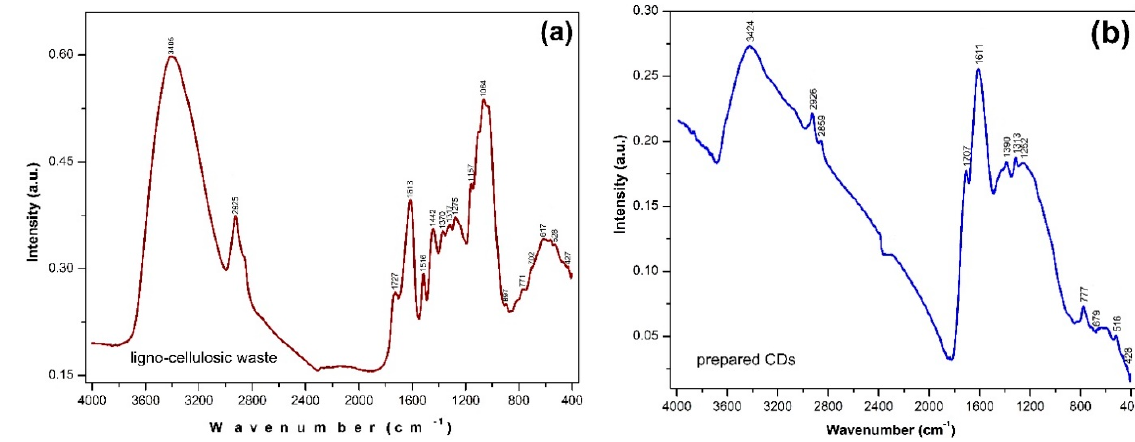
Figure 3. Recorded IR spectra for ( a ) the ligno − cellulosic waste and ( b ) the prepared CDs.